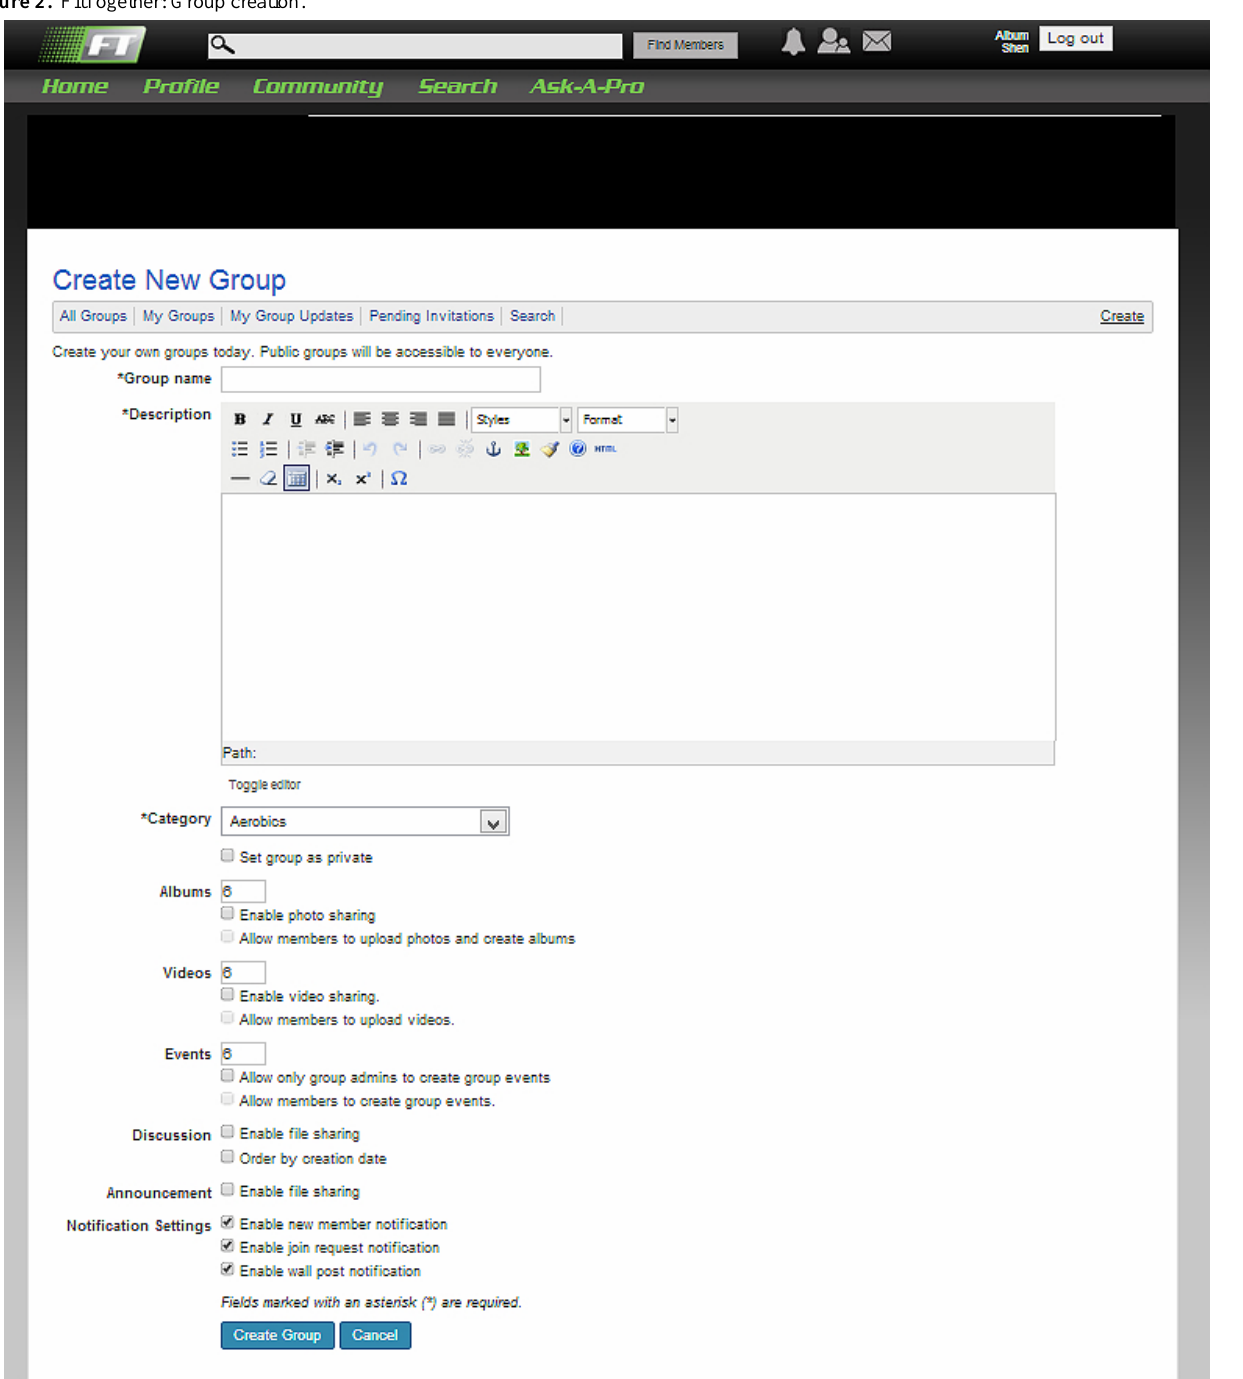
Figure 2. FitTogether: Group